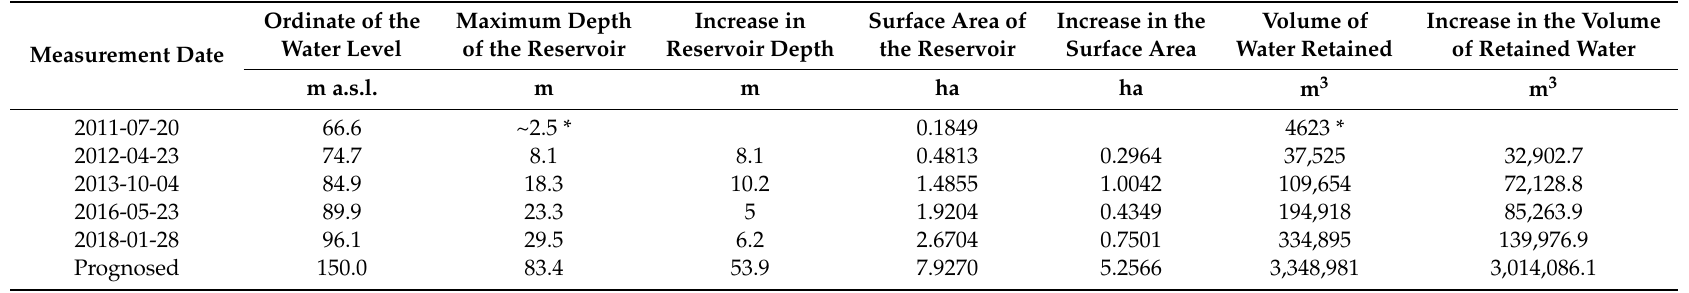
Table 1. Characteristics of the quarry lake in the Strzelin I quarry, based on the DTM created with use of LiDAR ALS data of 26–27 April